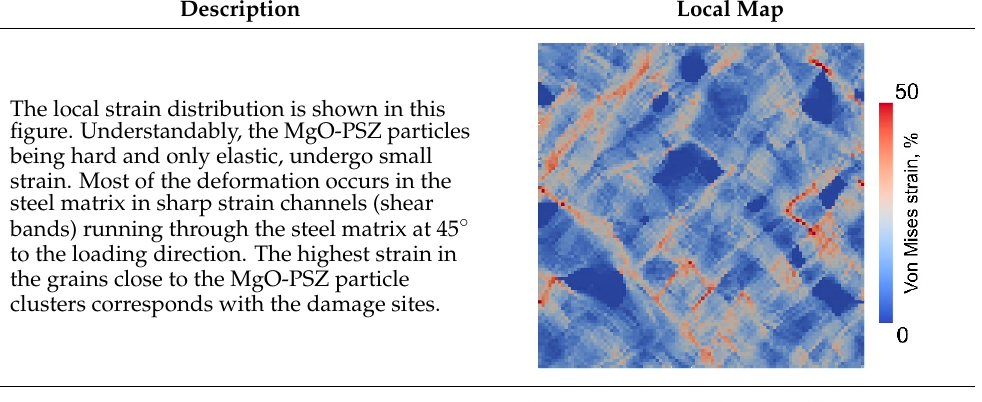
Table 4. Analysis of local stress, strain, transformation, and damage behavior at 20% global strain.